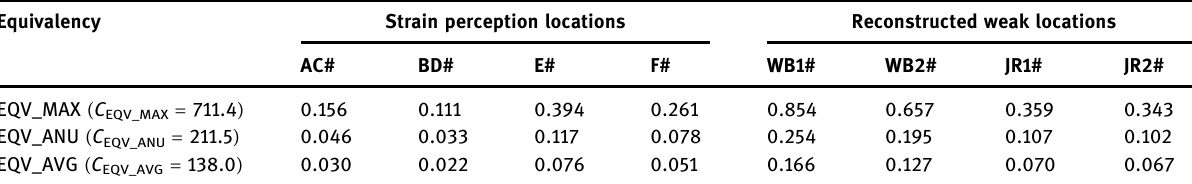
Table 5: Equivalent fatigue damage in full life mileage for strain perception and weak locations